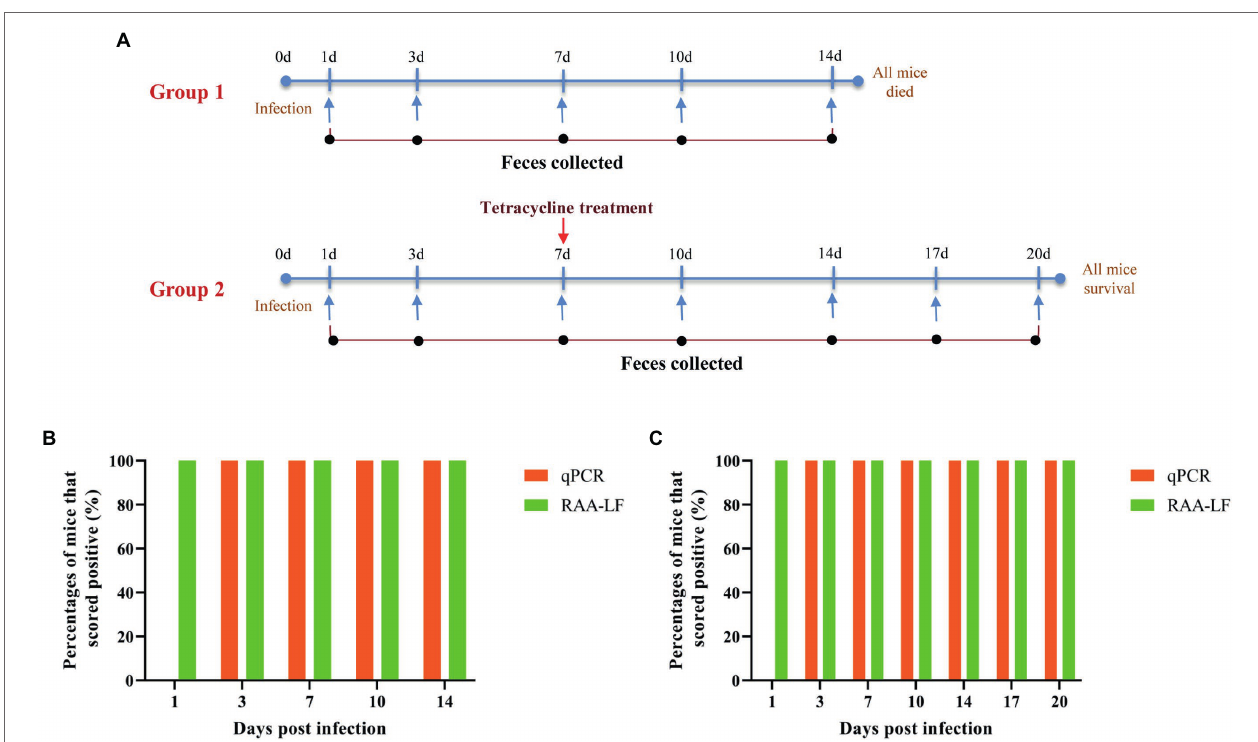
FIGURE 5 | Results of the evaluation of qPCR and the RAA-LF assay for experimentally infected samples. BALB/c mice infected with Chlamydia psittaci were divided into two groups of four individuals. Group 1 was left untreated, while Group 2 was treated with tetracycline at 7 days post-infection. All mice in group 1 died at day 15 post-infection and all mice in group 2 were survival (A) . Fresh feces samples from group 1 (B) and group 2 (C) were collected at days 1, 3, 7, 10, 14, 17 and/or 20 post-infection, and the extracted DNA from fresh feces samples were evaluated by qPCR and the RAA-LF assay. The results were displayed as the percentages of mice that scored positive (orange) or negative (green).